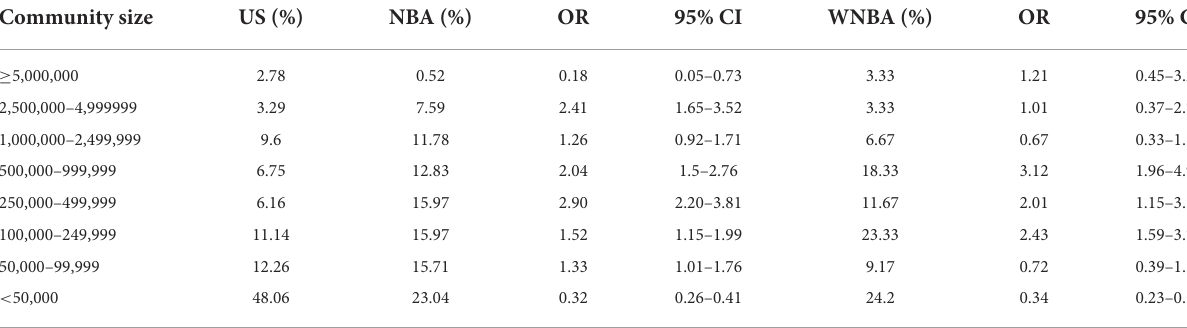
TABLE 3 Odds ratios (ORs) and confidence intervals (CIs) across city size categories for professional athletes. Community size